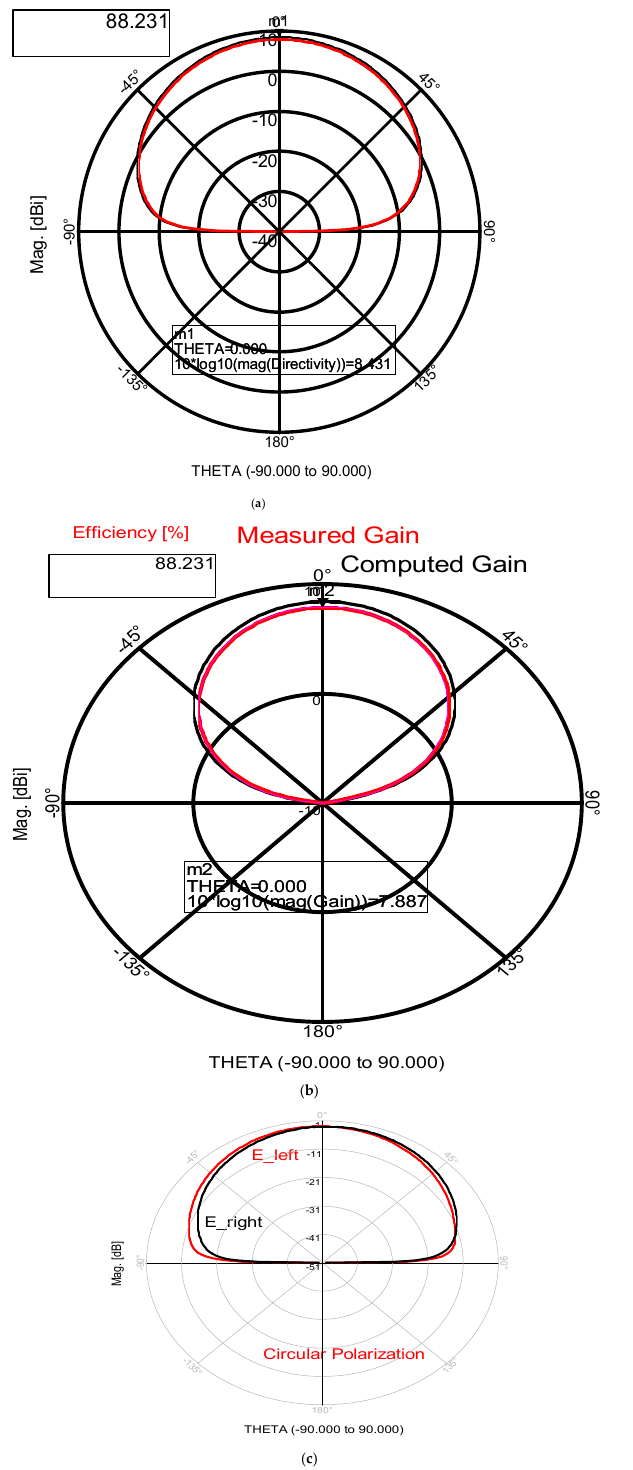
Figure 19. Polar radiation pattern of the Circular Polarized patch with CSRR. ( a ) Radiation pattern; ( b ) Computed and measured gain. ( c ) The circularity of the circular polarized sensor.